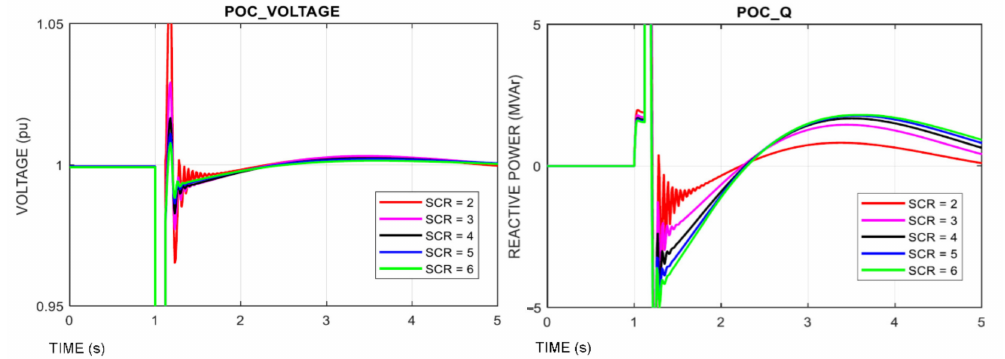
Figure 2. Result of Deep Fault Test: Voltage and Q response at POC.